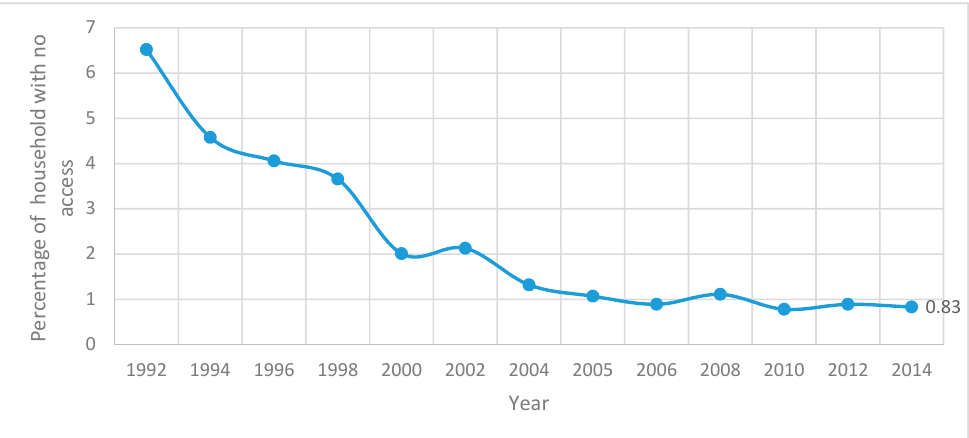
Figure 3. Households with no access to electricity. Mexico 1992–2014. Percentage. Source: Authors’ calculations, ENIGH (1992–2014).